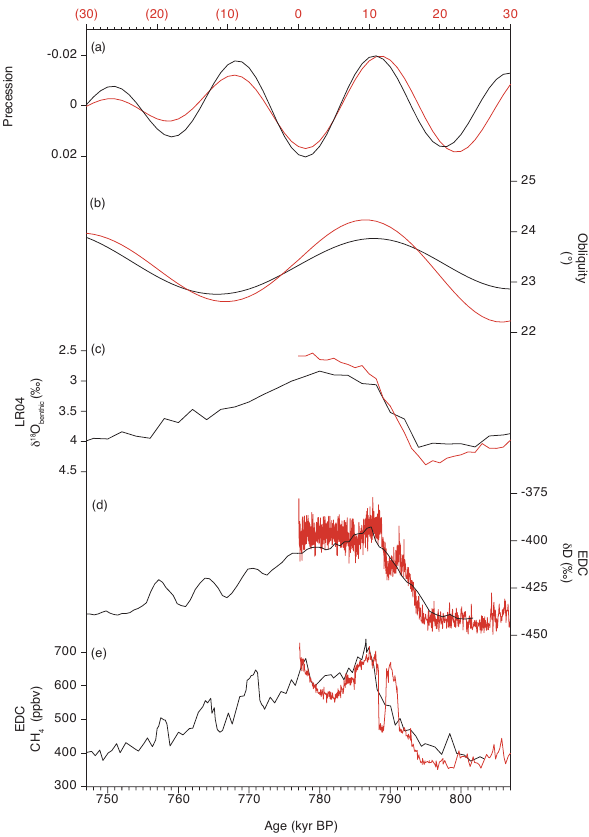
Fig. 7. Precessional (and also obliquity) alignment of the past and future 30kyr (red) and a 60-kyr interval encompassing MIS 19 (black). (a) precession index, plotted on an inverse vertical axis (Berger and Loutre, 1991); (b) obliquity (Berger and Loutre, 1991); (c) δ 18 O benthic record from the LR04 stack (Lisiecki and Raymo, 2005), plotted on its own timescale; (d) δD composition of ice in the EDC ice core, Antarctica (Jouzel et al., 2007), plotted on the EDC3 timescale; (e) atmospheric CH 4 concentration from the EDC ice core (Loulergue et al., 2008), plotted on the EDC3 timescale. Ages in parentheses denote thousand years after present (kyr